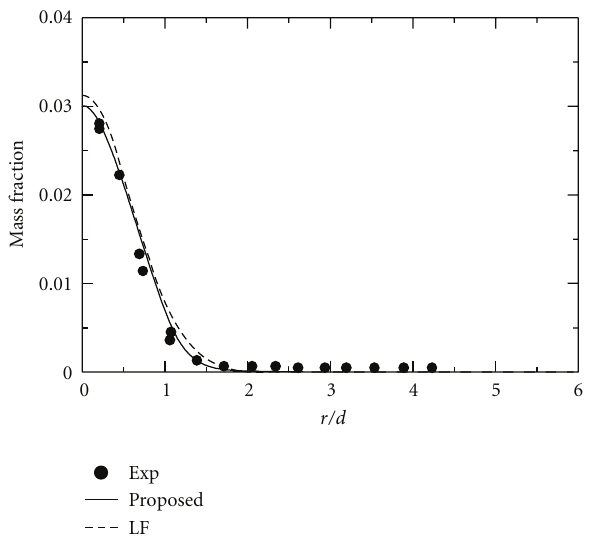
Figure 16: Radial mass fraction of H 2 at x/d = 10.